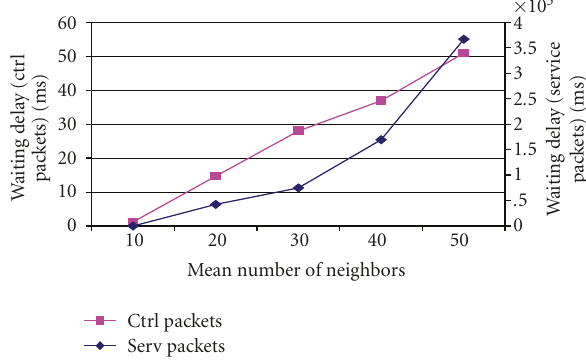
Figure 15: Delay versus Mean Number of Neighbors (message generation rate = 150 msgs/s and mean message size = 500 bytes).